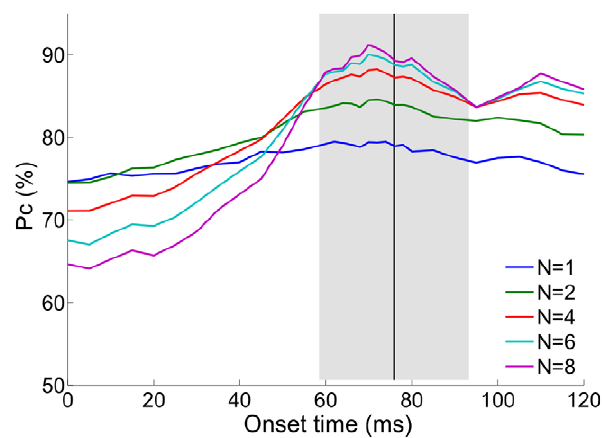
Figure 8. Effect of onset time on orientation discrimination using the first spike latency. To investigate the effect of onset time, we measured the spike times relative to an artificial reference signal. The curves show the probability of correct discrimination (Pc) as a function of onset time for two populations that differ in preferred orientation by 90 u . Each curve corresponds to a different population size, N (see legend). The black vertical line and the gray band represent the mean onset time 6 1 standard deviation using the onset detection mechanism. tuned neurons ( B . 15 ms) in each dataset were divided into M ‘columns’ according to their preferred orientation, as depicted in Figure 9A (see Materials and Methods). Note that the number of